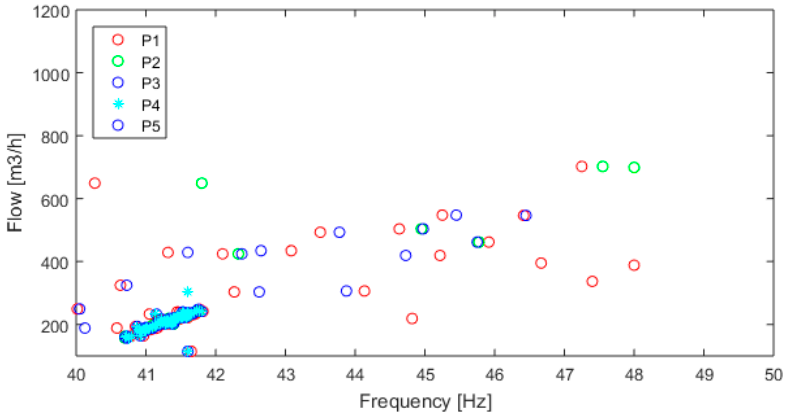
Figure 17. The characteristic F = f ( D i ) for the hydraulic regime with four pumps in operation.